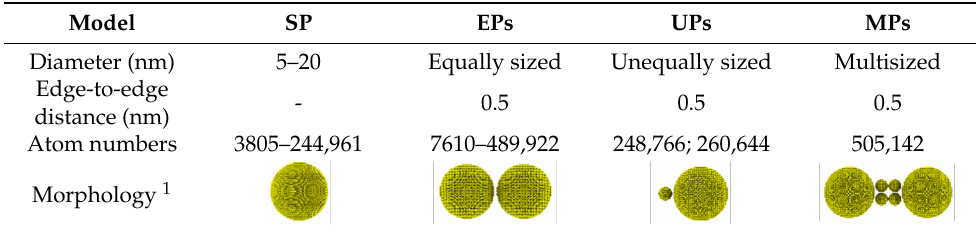
Table 1. Configuration of the simulation models in this